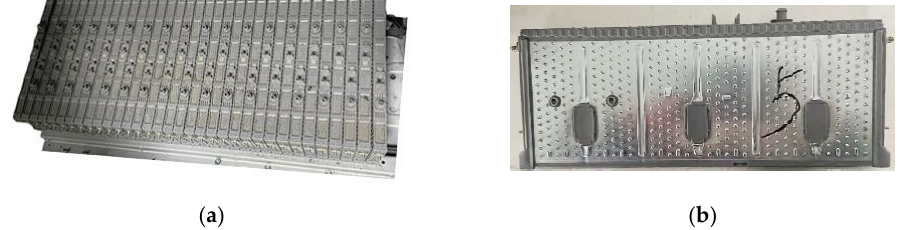
Figure 1. ( a ) Distribution map of Ni-MH battery modules; ( b ) exterior diagram of a Ni-MH bat- tery